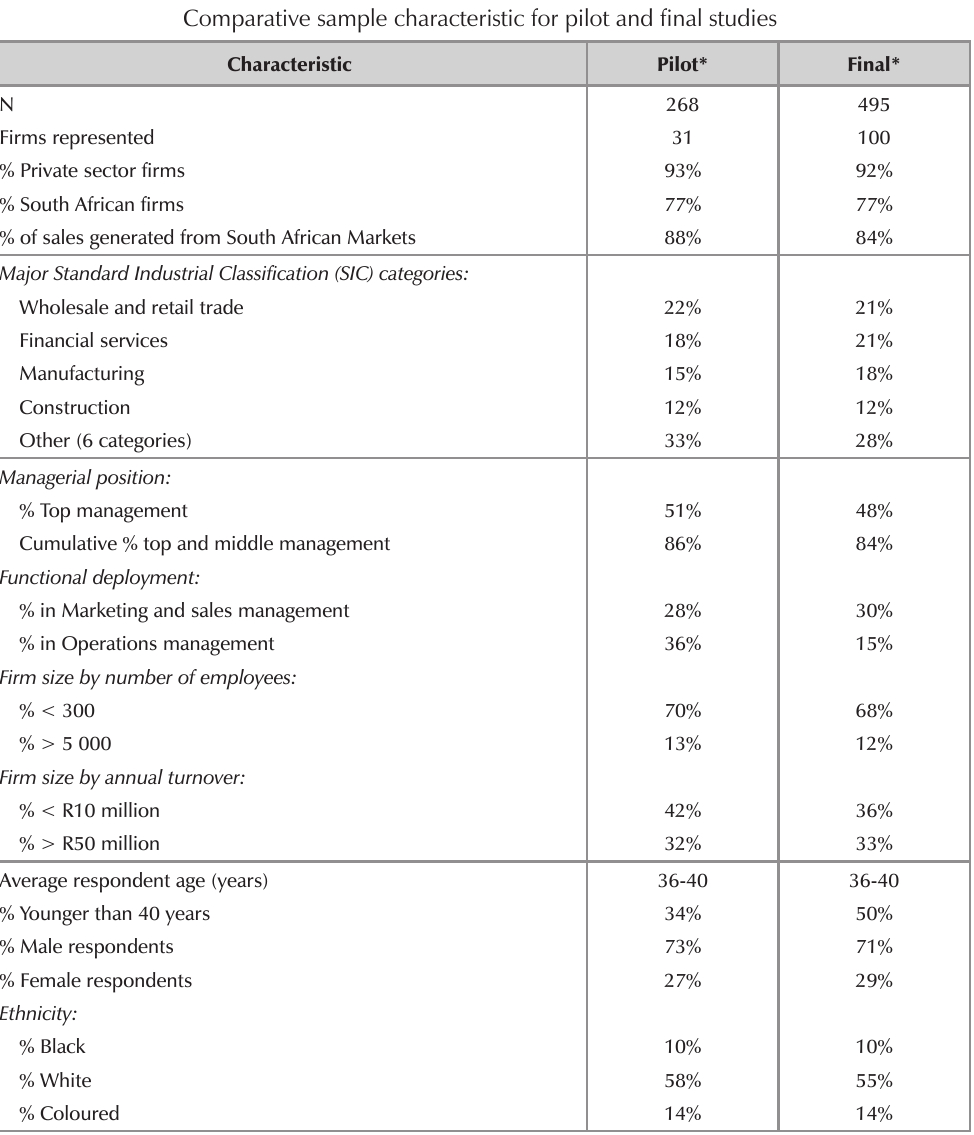
Comparative sample characteristic for pilot and final studies Characteristic